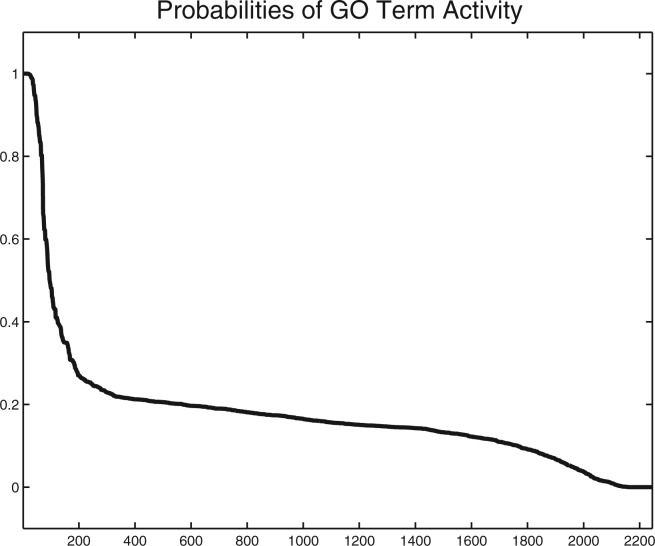
This figure shows probabilities of GO term activity, P(Gk |D), ranked in decreasing order. GO term inference is based on indicator probabilities which assess shared gene activity. As a result, we find 95 active GO terms that have activation probabilities larger than 0.5. Assuming independence of GO term activity, the false discovery rate among these 95 genes is about 15%